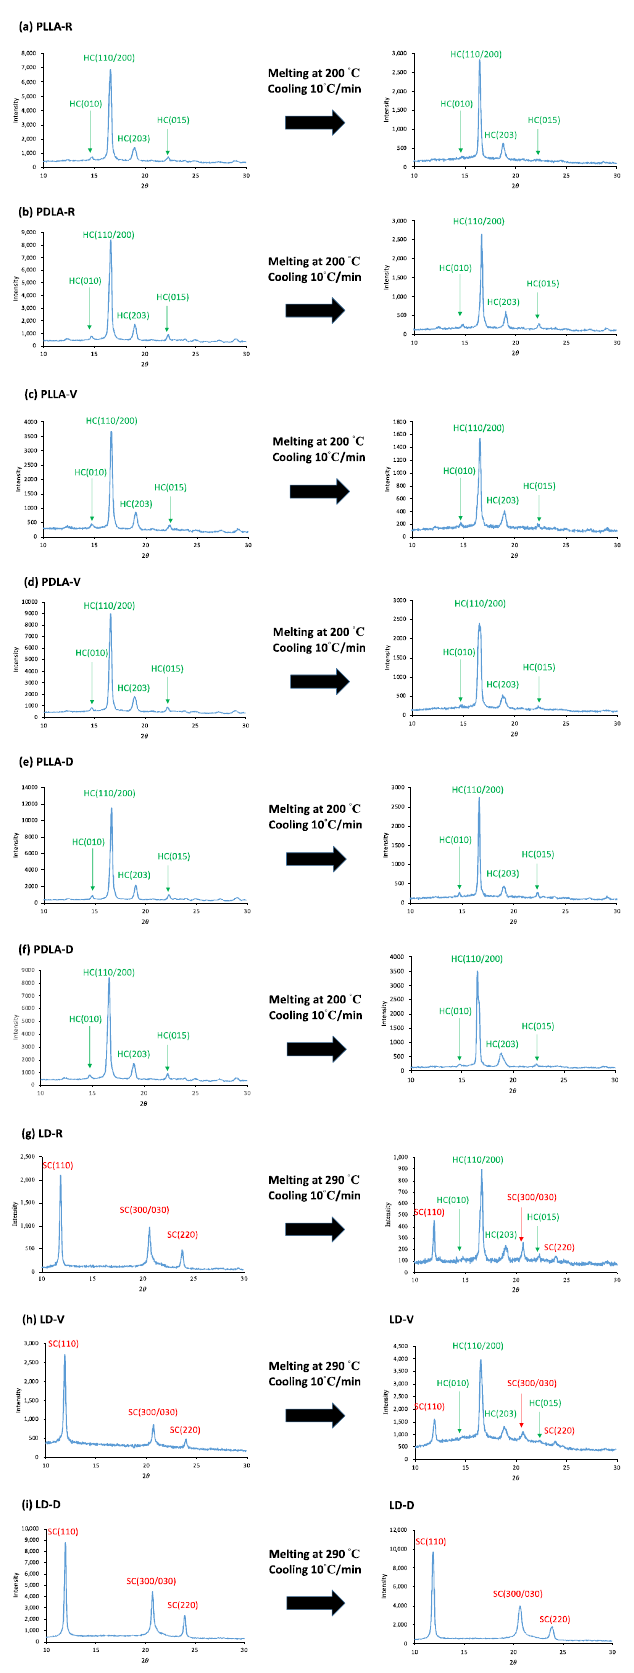
Figure 9. Wide-angle X-ray diffraction (WAXD) profiles of ( a ) PLLA-R, ( b ) PDLA-R, ( c ) PLLA-V, ( d ) PDLA-V, ( e ) PLLA-D, ( f ) PDLA-D, ( g ) LD-R, ( h ) LD-V, and ( i ) LD-D before and after melting